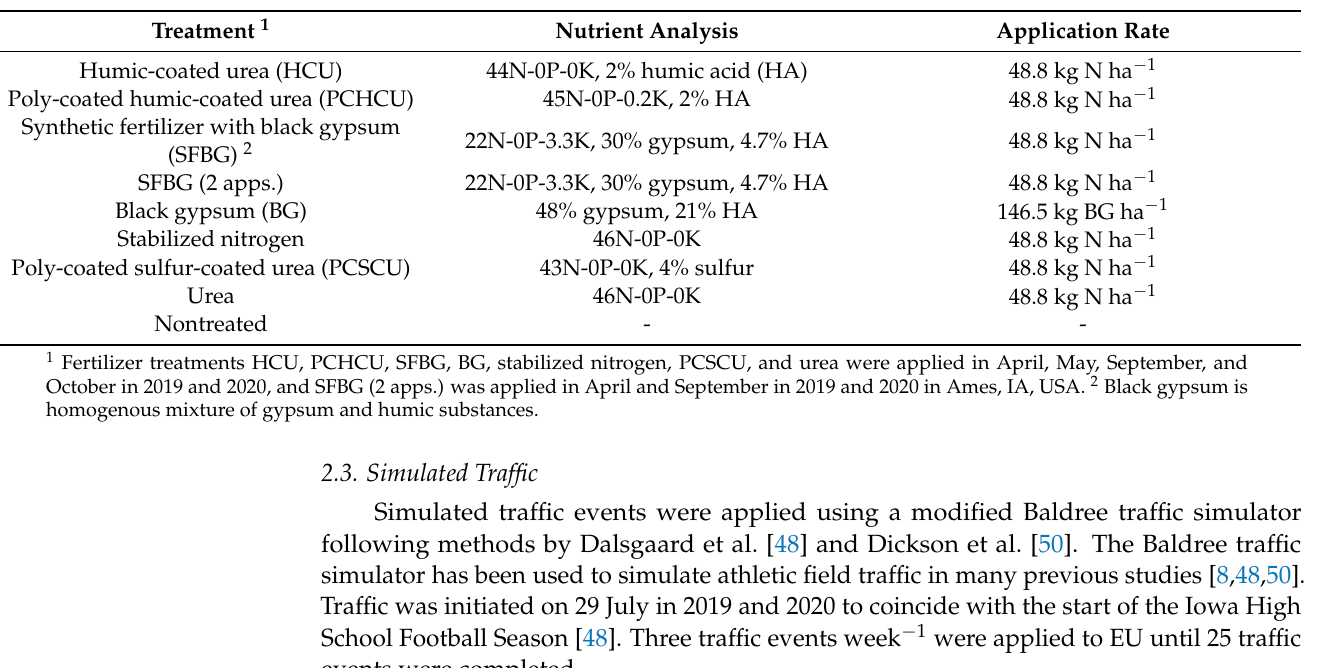
Table 1. Fertilizer treatments, nutrient analysis, and application